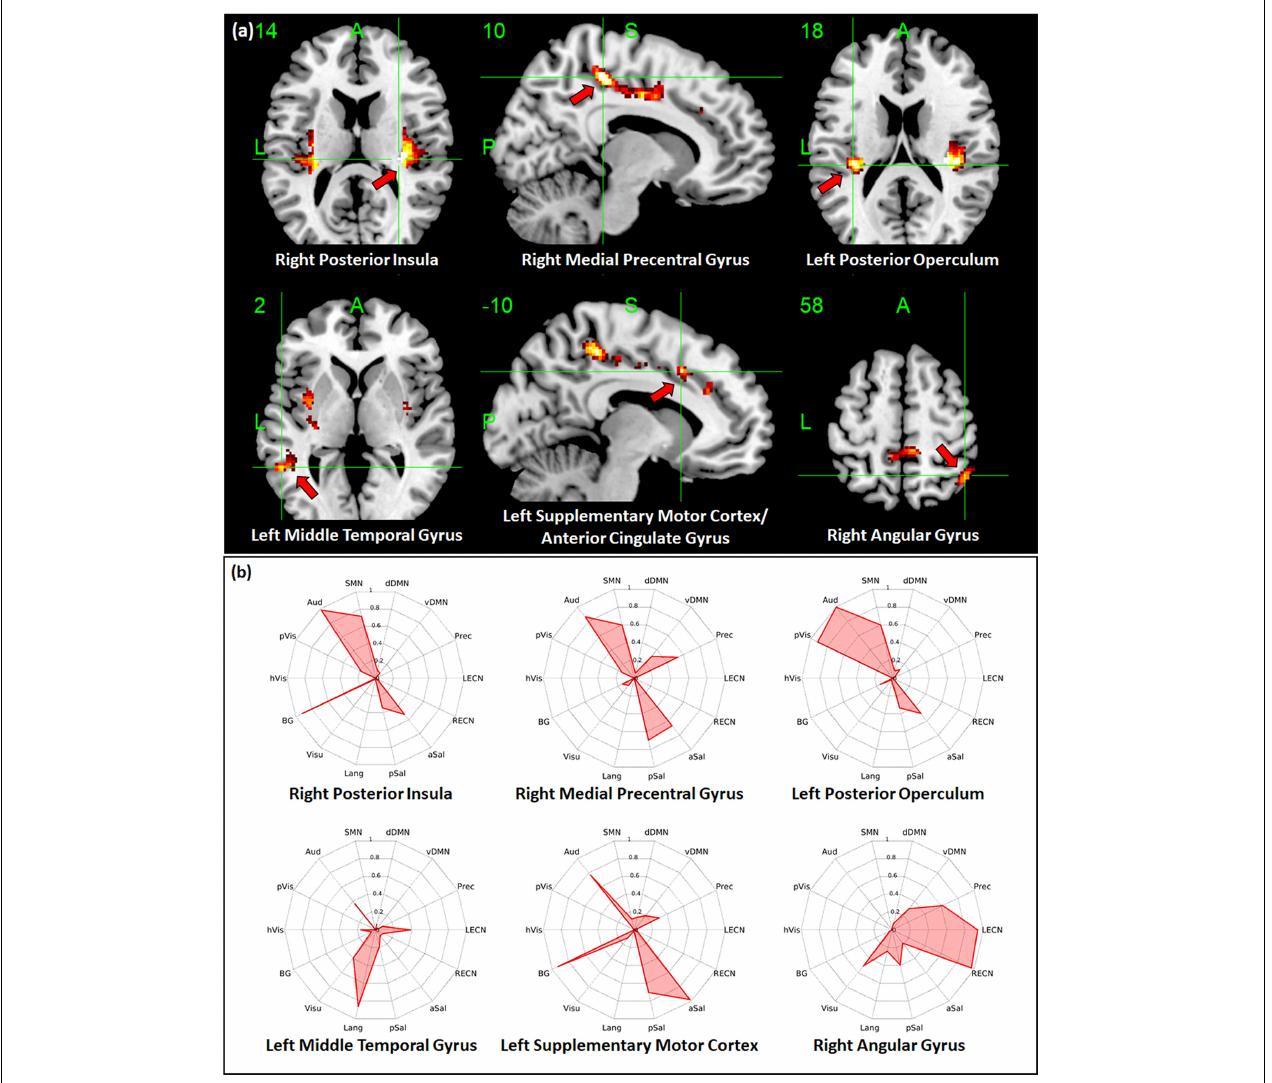
FIGURE 3 | Relationship between whole-brain intrinsic connectivity contrast (ICC) values and age. (a) Regions with whole-brain ICC values that showed significant (FWEc p < 0.05, CDT p = 0.001) negative linear relationship with age. (b) Spider plots of the overlap ratio quantifying the connection between the 14 canonical resting state networks and the regions shown in (a) . dDMN, dorsal default mode network; vDMN, ventral default mode network; Prec, precuneus network; LECN, left executive control network; RECN, right executive control network; aSal, anterior salience network; pSal, posterior salience network; Lang, language network; Visu, visuospatial (dorsal attention) network; BG, basal ganglia network; hVis, high visual network; pVis, primary visual network; Aud, auditory network; SMN, sensorimotor network; R, right; L, left.